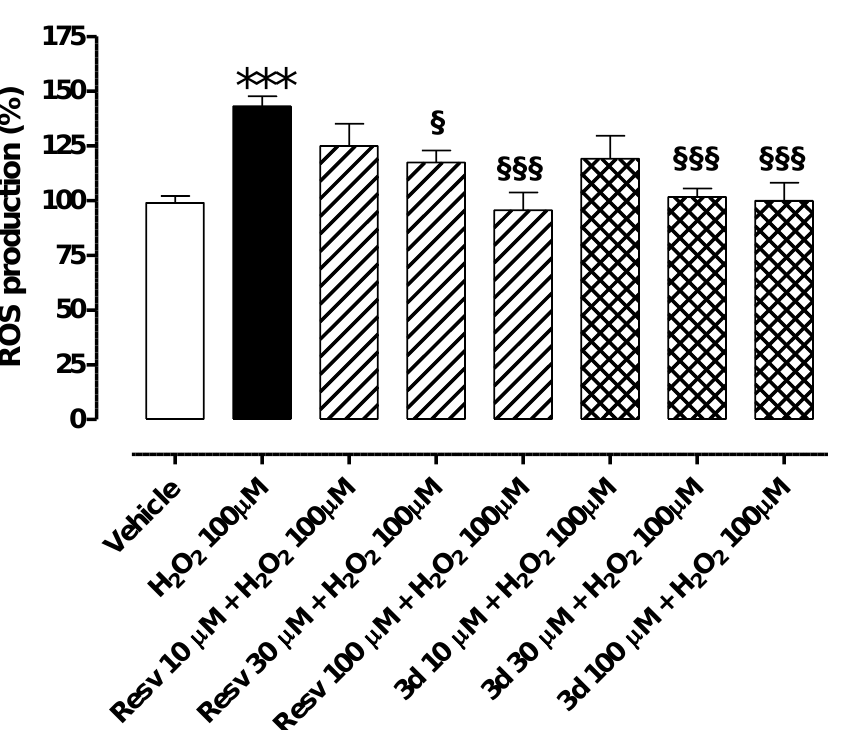
Figure 9. Preventive effects of resveratrol and 3d against H 2 O 2 -induced intracellular ROS production in HUVECs. Bars indicate intracellular ROS production (%) in HUVECs exposed to H 2 O 2 100 µ M for 2 h. Pre-incubation of resveratrol (Resv) and 3d (10, 30, and 100 µ M) for 1 h prevented H 2 O 2 -induced ROS production in a concentration-dependent manner. Data are shown as mean ± SEM. * indicates significant difference vs. vehicle (*** p < 0.001) while § indicates significant difference vs. H 2 O 2 100 µ M (§ p < 0.05; §§§ p < 0.001).